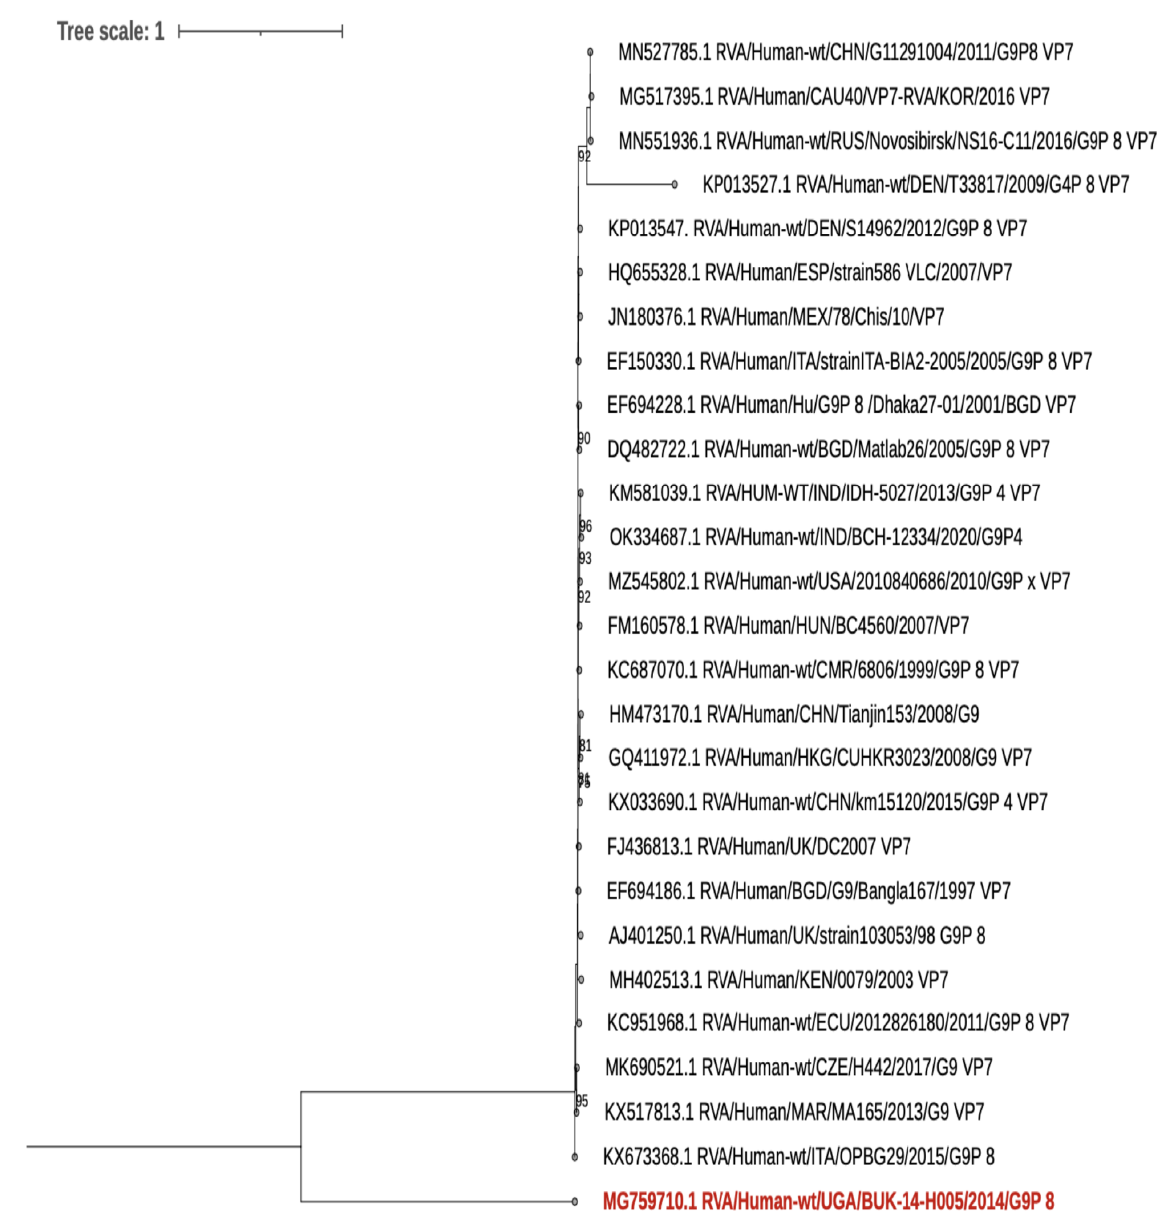
Figure 1. VP7. A Maximum-likelihood phylogenetic tree based on the Hasegawa–Kishono–Yano plus empirical base frequencies plus FreeRate model generated using IQ-TREE (3) and run for 1000 pseudo replicates. The tree was midpoint rooted and bootstrap values greater than 75% are shown at the nodes. The study human strain is in red.